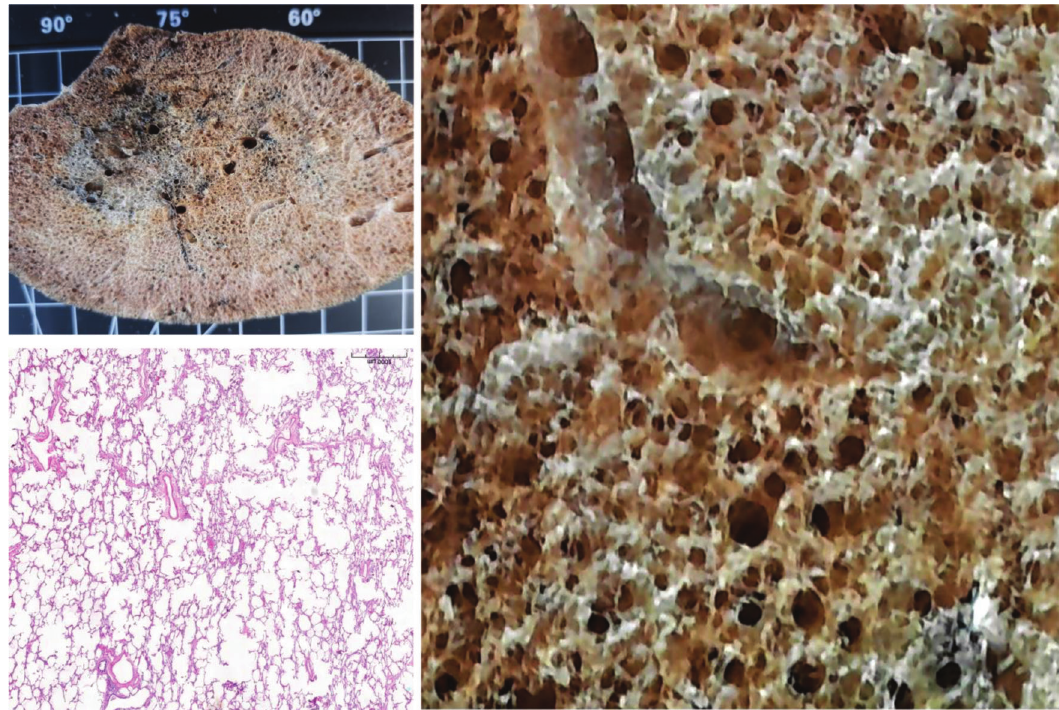
Figure 1 - Example of a non-COVID-19, preserved lung, fixed with gaseous formaldehyde at 30 cm H 2 O for 48h. Lung parenchyma shows preserved architecture and normal histology, except for areas of anthracosis (black dots in upper left panel).